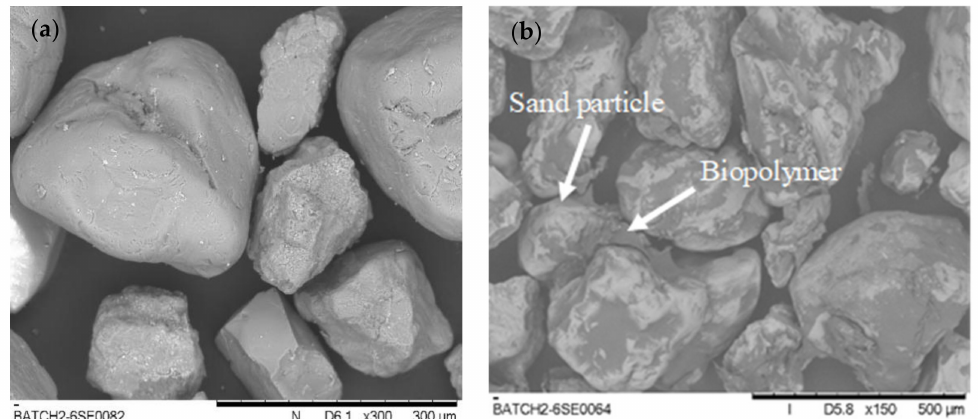
Figure 3. SEM image of biopolymer treated sand and clean sand (( a ): clean sand with 300 magnification; ( b ): biopolymer treated sand with 150